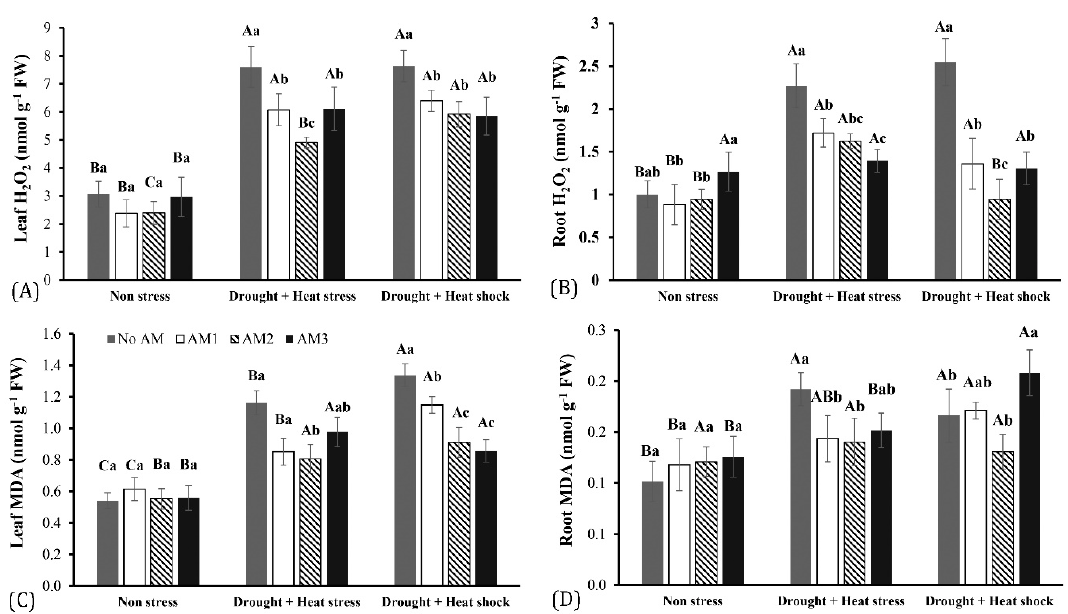
Figure 1. Hydrogen peroxide (H 2 O 2 ) and malonaldehyde (MDA) accumulation in leaves ( A , C ) and roots ( B , D ) of non-inoculated plants (No arbuscular mycorrhizal (AM) and plants inoculated by R. irregularis (AM1), F. mosseae (AM2), or F. coronatum (AM3) subjected to non-stress (NoS), drought + heat stress, and drought + heat shock. Each bar represents the mean and standard deviation (n = 4). Different minuscules indicate significant difference among treatments under the same conditions (no stress, drought + heat stress, or drought + heat shock) by Duncan’s post hoc test at p ≤ 0.05. Different capital letters indicate significant differences of the same treatments (No AM, R. irregularis, F. mosseae, or F. coronatum ) under different conditions (no stress, drought + heat stress, and drought + heat shock) by Duncan’s post hoc test at p ≤ 0.05.